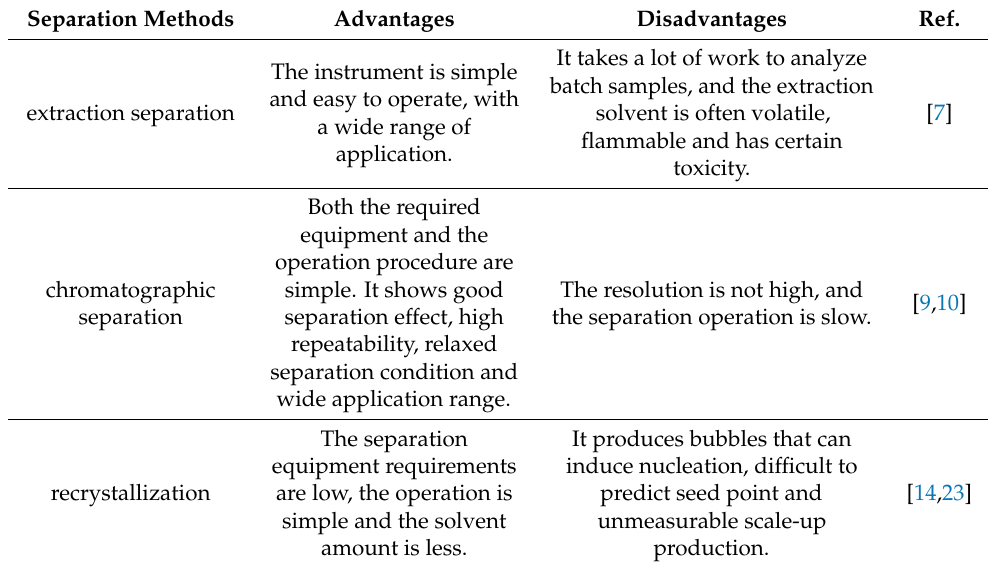
Table 1. Comparison of several separation methods for TCM. Separation